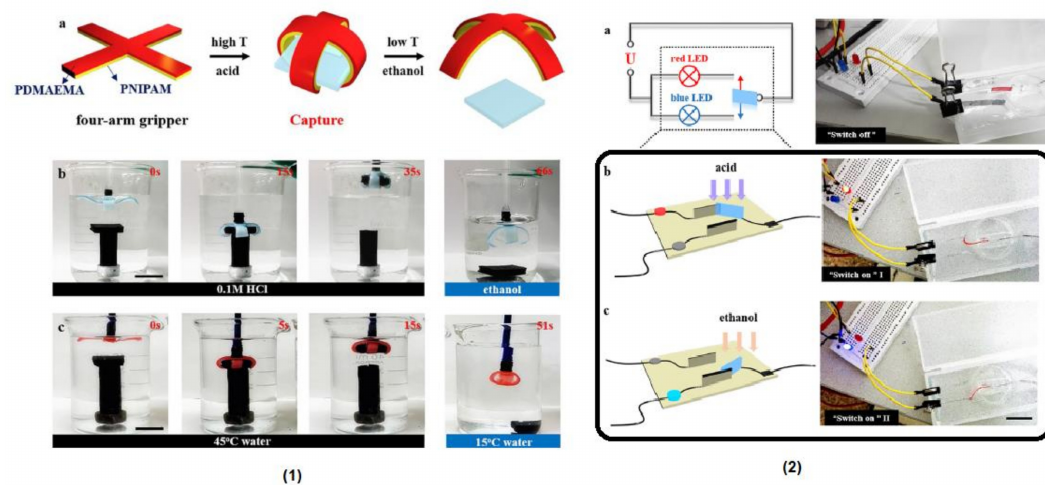
Figure 41. ( 1 ) Scheme (a) and photographs of bilayer hydrogel as a four-arm gripper to capture the weight in response to pH (b) and temperature (c). ( 2 ) Scheme and photographs of the bilayer-type hydrogel as the bidirectional circuit switches: the disconnected state (a) and the connected state that turns on the red (b) or blue (c) light emitting diodes (LEDs). Reprinted from [218], Copyright (2018), with permission from